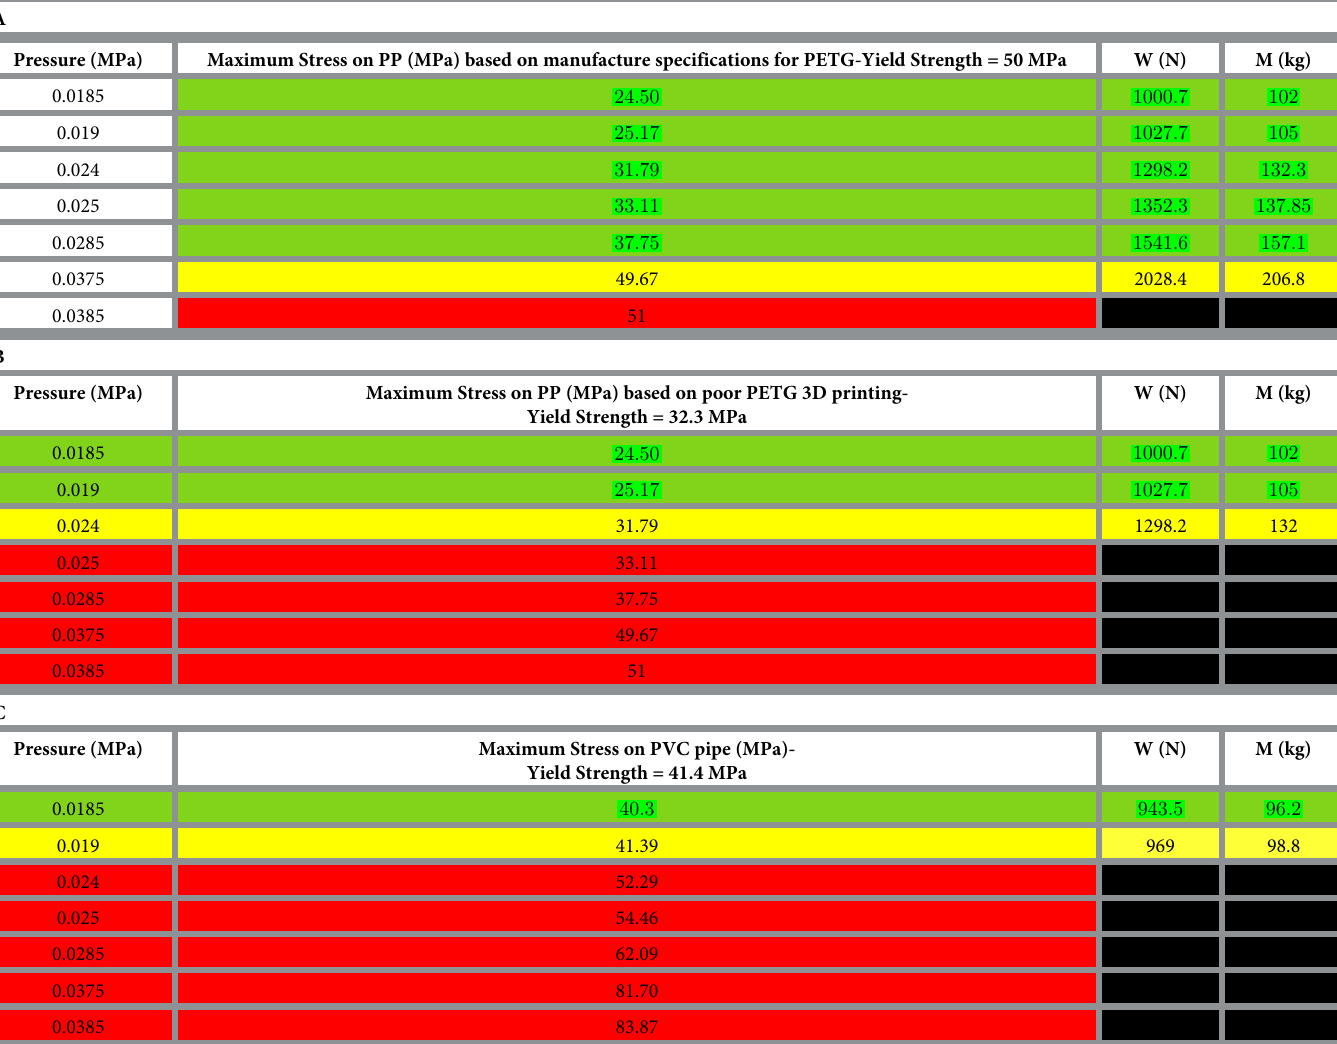
Table 5. a. Effect of stress on PP with manufacture specifications. b. Effect of stress on PP with poor 3-D printing. c. Effect of stress on PVC pipe. A Pressure